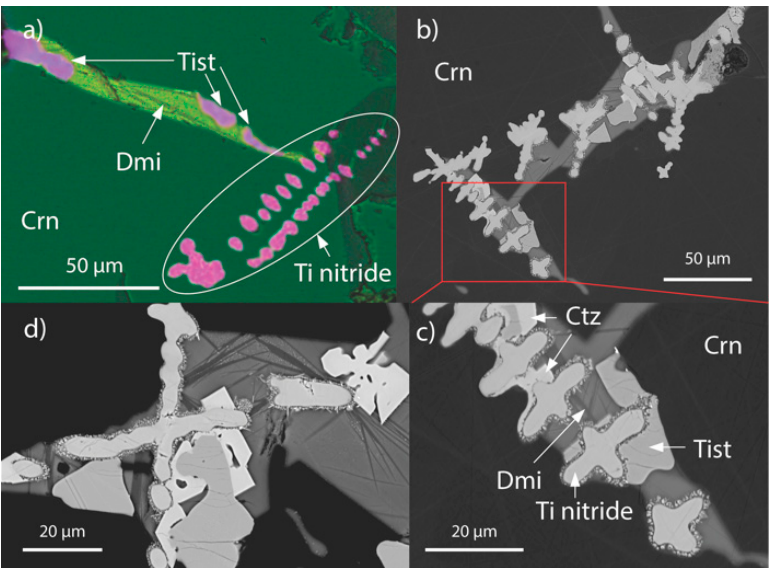
Figure 3. ( a ) SEM-EDS phase map showing silicate melt pocket in corundum, and trains of Ti nitride inclusions outlining an earlier skeletal cavity system, necked down by continued growth of the corundum. ( b ) BSE image showing Ti nitrides intersecting an interstitial silicate melt pocket in corundum, breaking down into spheroidal and cruciform blobs. ( c ) Enlargement of ( b ), showing emulsion of Ti nitride in silicate glass separating Ti nitride blobs from silicate melt. Oxide phases appear to wrap around the nitride bodies, but this may be a sectioning effect. ( d ) BSE image of elongated Ti nitride bodies in the process of necking down into individual circular bodies. Development of emulsion rims appears to postdate crystallization of carmeltazite against the nitride bodies in some places. Abbreviations: Crn, corundum; Ctz, carmeltazite; Dmi, dmisteinbergite (identified by Raman spectrum; a polymorph of anorthite (CaAl 2 Si 2 O 8 ); Tist, tistarite.